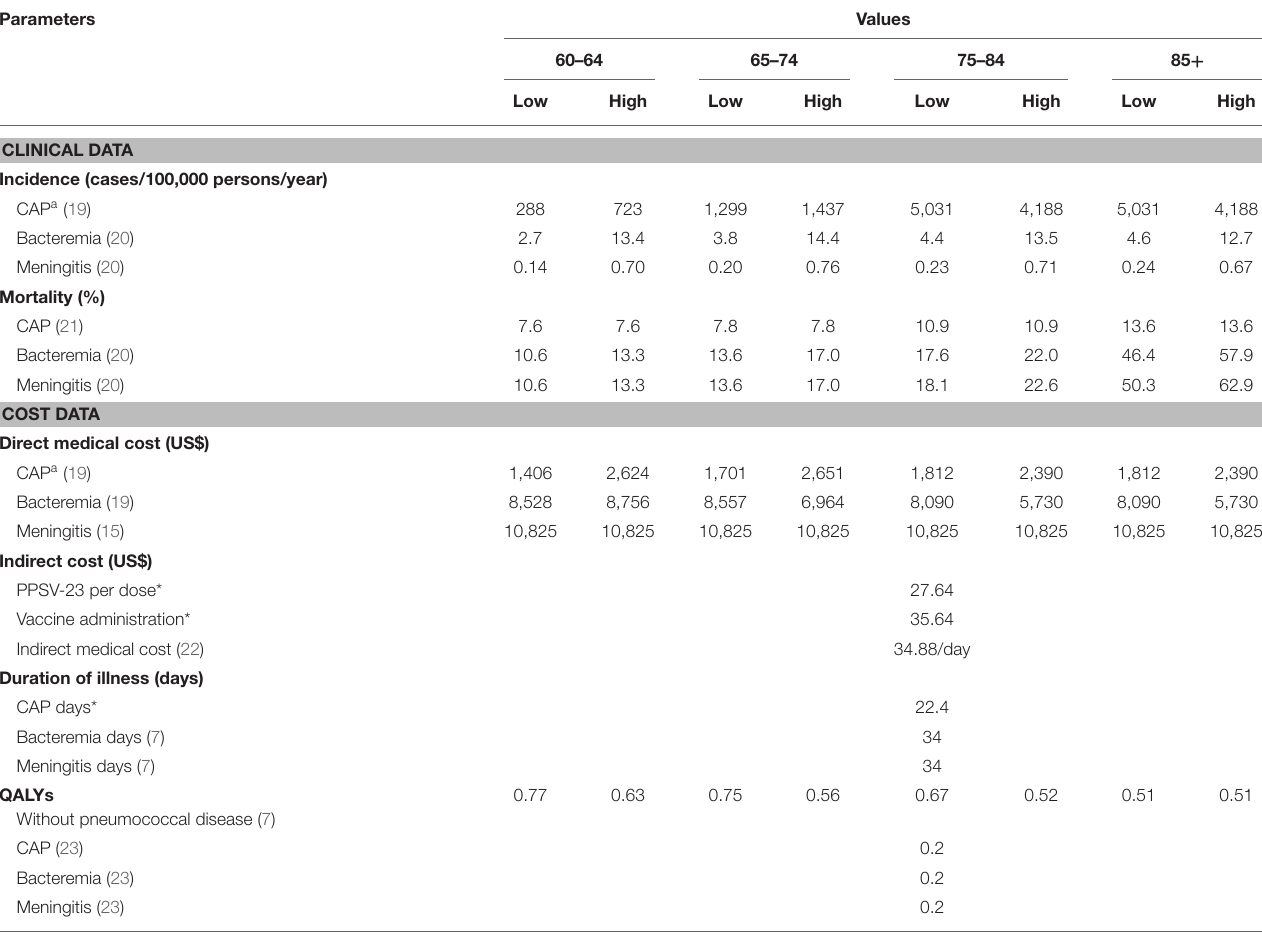
TABLE 1 | The epidemiological, medical cost, and QALYs of the pneumococcal diseases.